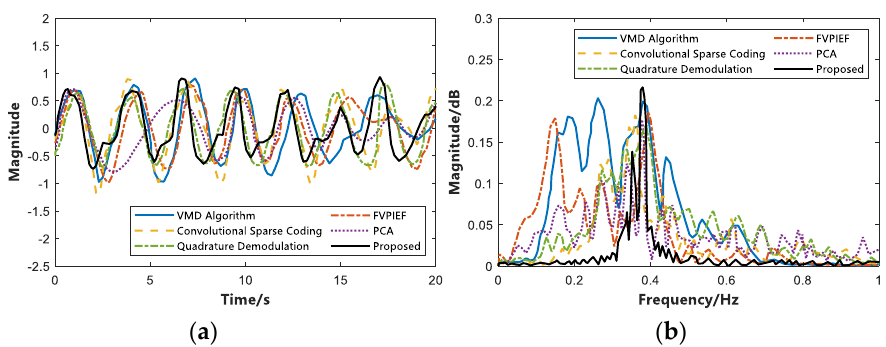
Figure 13. Time domain and frequency domain of breathing estimation using different algorithms. ( a ) Time domain diagram of breathing estimation. ( b ) Frequency domain diagram of breathing estimation.